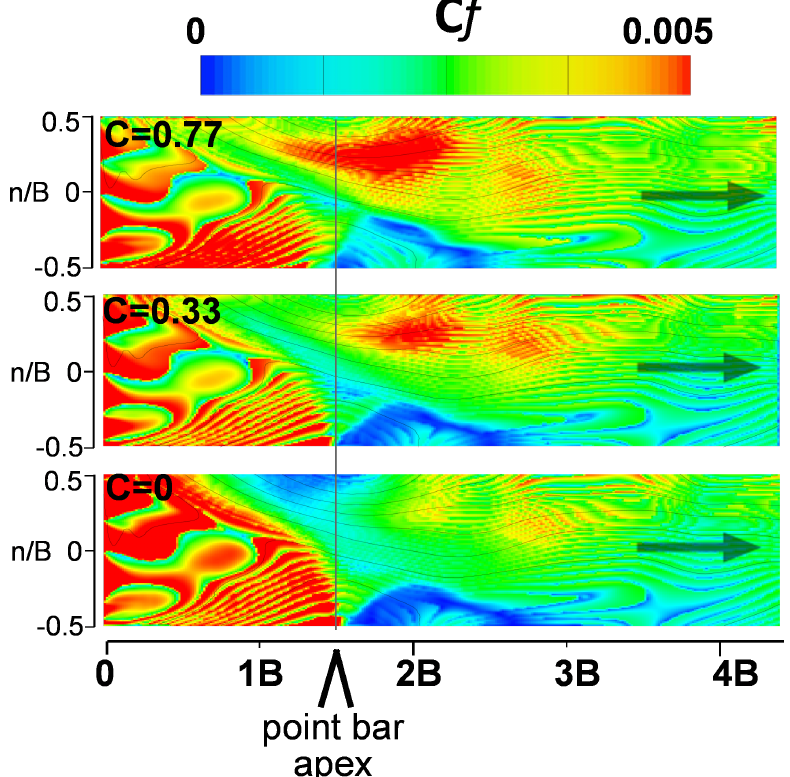
Figure 9. Distribution of river channel bed shear Cf for channel curvature C = 0.77, 0.33, and 0